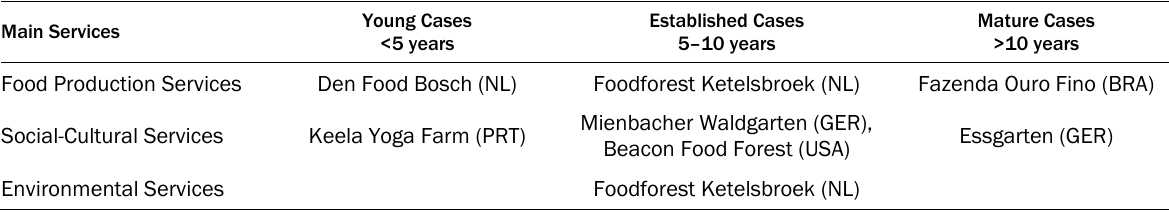
Table 1. Overview of Food Forests Selected for this Study Main